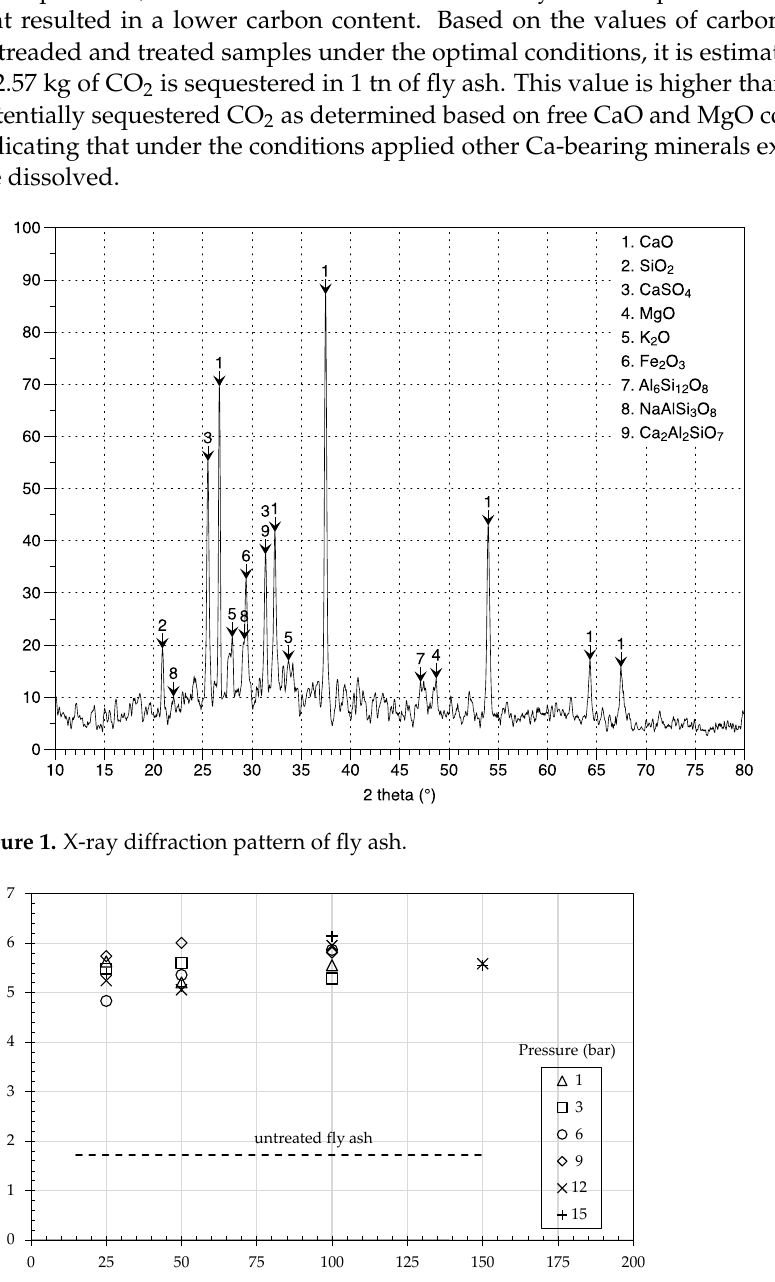
Figure 2. Total carbon content in fly ash vs. temperature and total pressure.